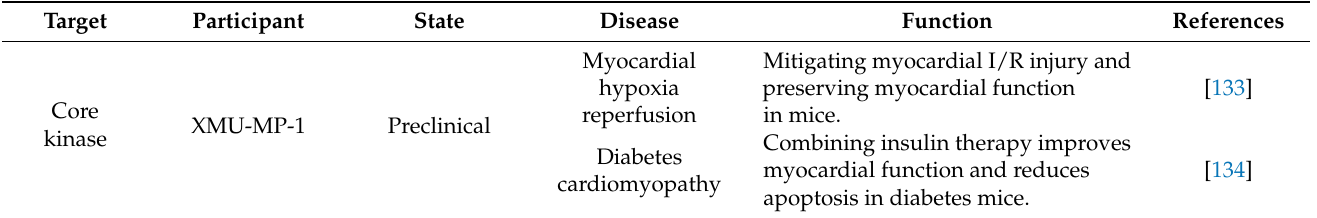
Table 2. Potential drugs targeting YAP/TAZ and its upstream and downstream pathways in pre- clinical trials and clinical